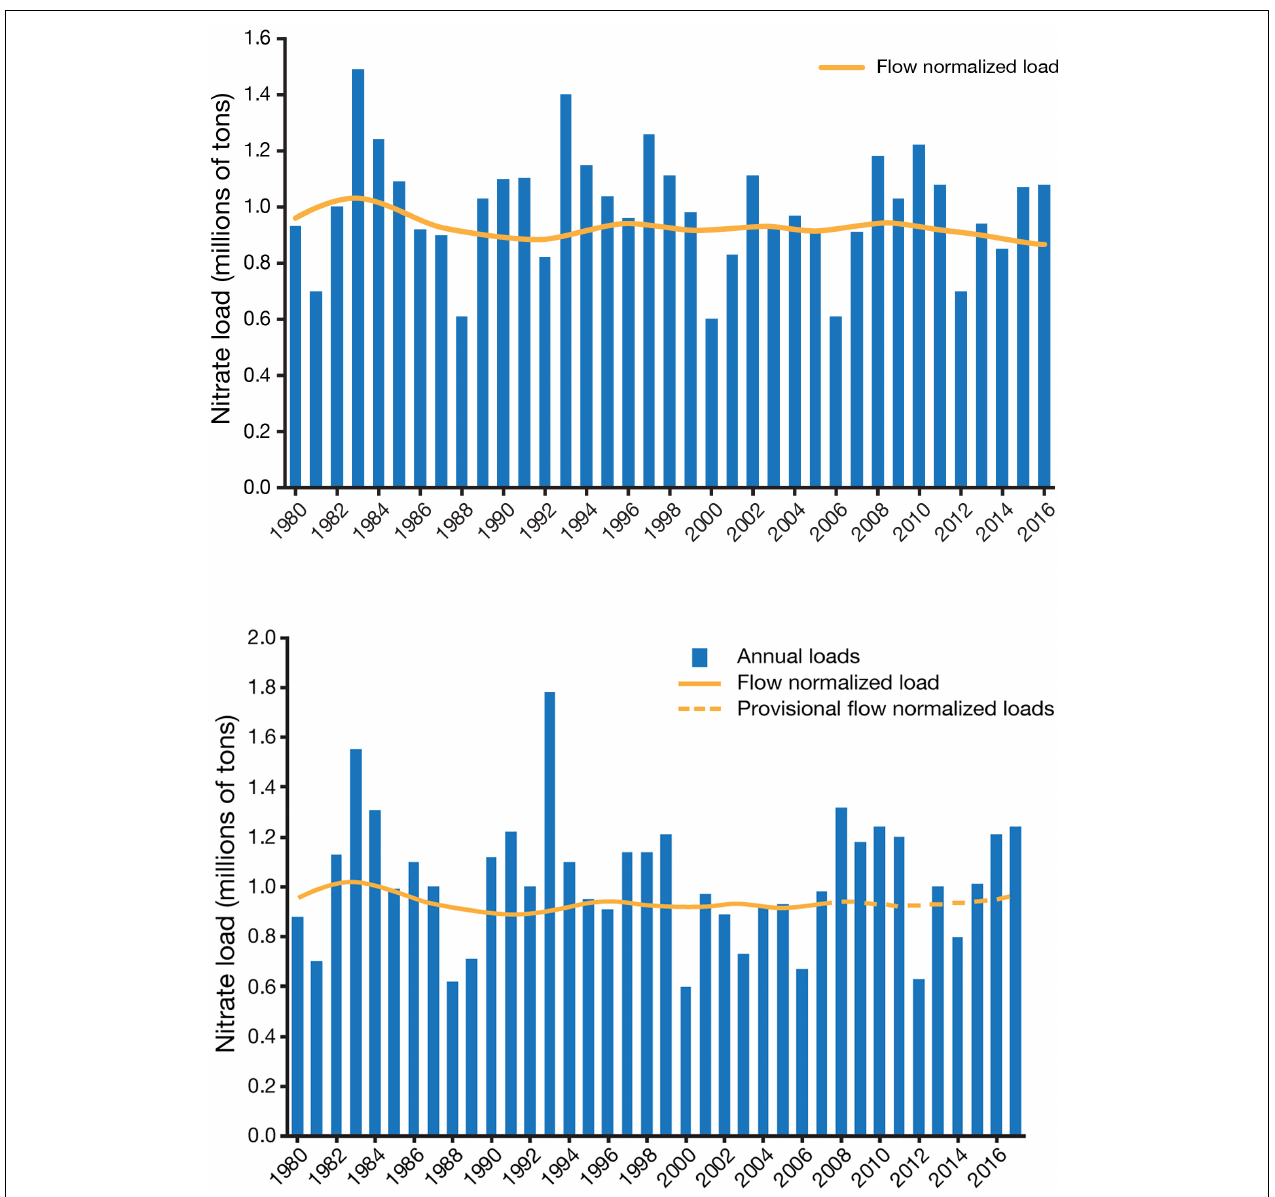
FIGURE 4 | Annual nitrate loading to the Gulf of Mexico from the Mississippi-Atchafalaya River Basin compared to the flow-normalized load based on weighted regressions on time, discharge and season, using methods described by Sprague et al. (2011). Modified from https://nrtwq.usgs.gov/mississippi_loads/#/GULF; accessed on 12 February 2019. Loading estimates produced by Lori Sprague and Casey Lee, U.S. Geological